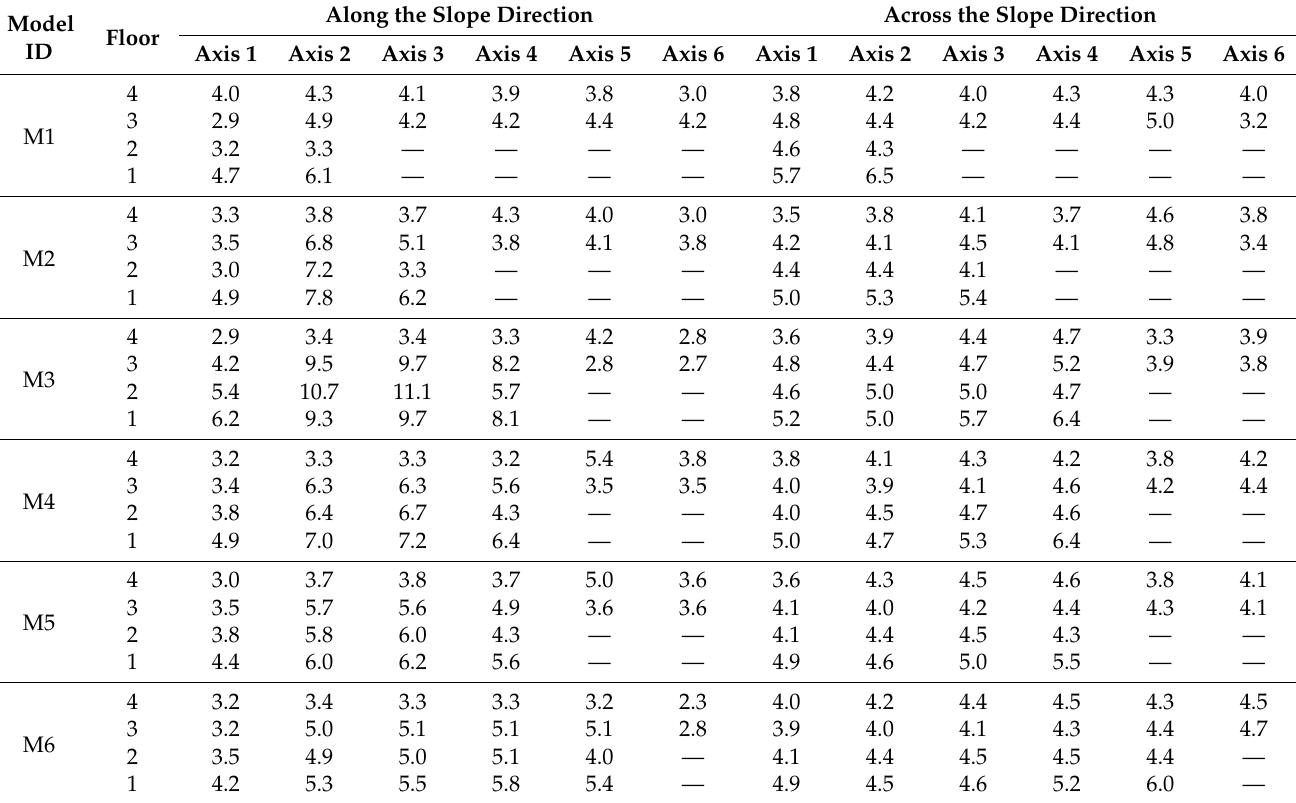
Table 7. The average λ of columns along and across the slope direction at a PG, x of 0.62